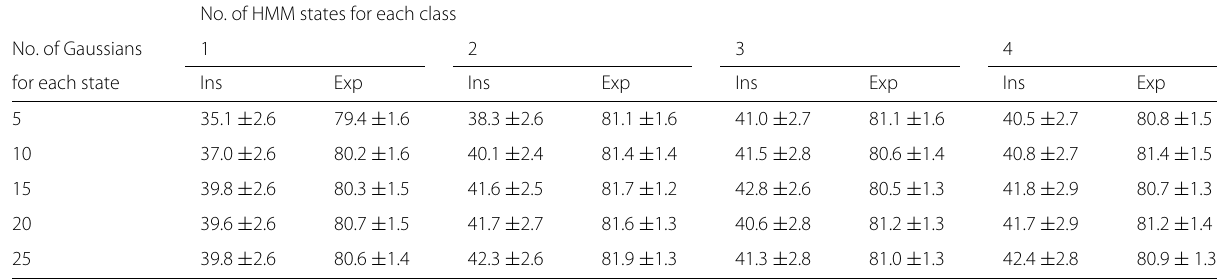
Table 3 F scores (%) of the expiratory and inspiratory phase classes, denoted by Exp and Ins, respectively, with different number of HMM states and component Gaussians No. of HMM states for each class No. of Gaussians 1 2 3